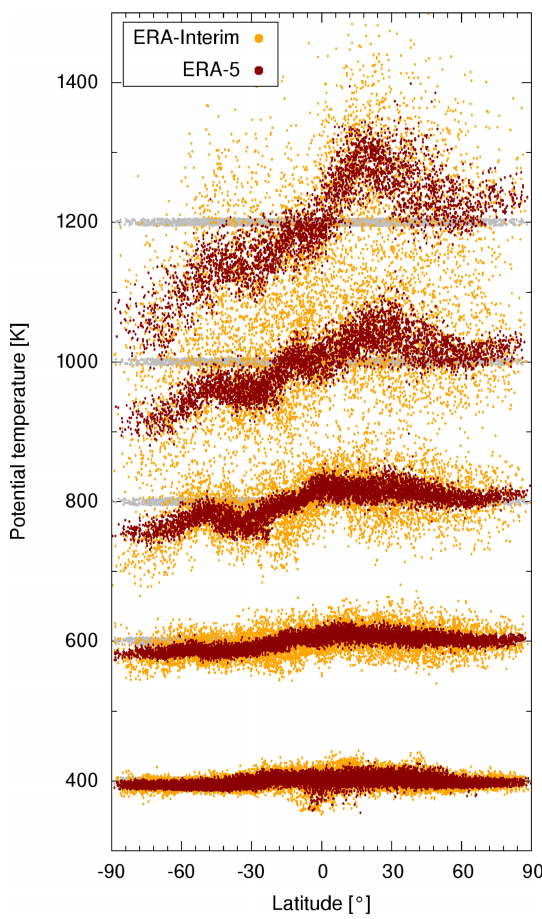
Figure 13. Dispersion of 10-day forward trajectories launched on 1 July 2017 at isentropic levels of 400, 600, ... , 1200K (an altitude of about 16, 24, ... , 48km; gray dots). The number of trajectory seeds varies between 12800 at the 400K isentropic level and 3400 at the 1200K isentropic level. The ERA-Interim simulations (or- ange dots) exhibit a larger scatter than the ERA5 simulations (red dots) after 10 days, especially at the uppermost height